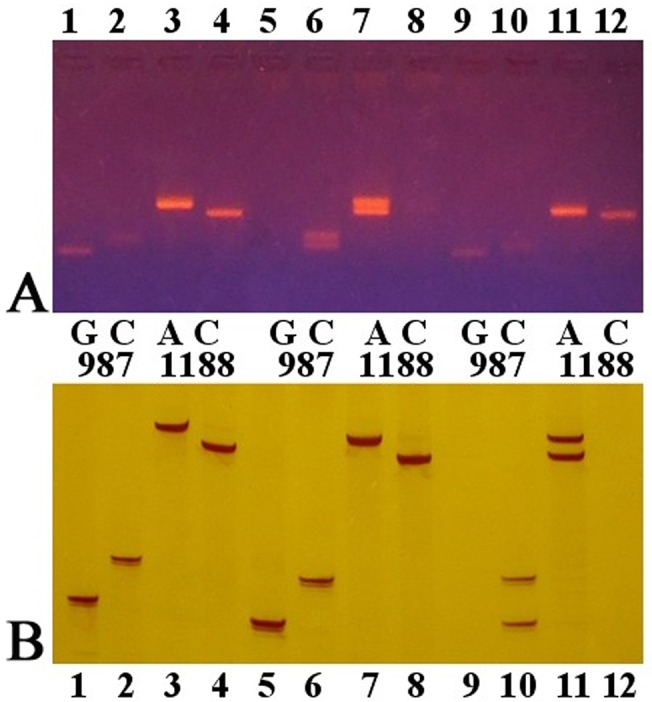
Detection of the haplotypes defined by C987GG/G987GG and TAA1118/TAC1118 via agarose gel electrophoresis (A) and polyacrylamide gel electrophoresis (B). Lanes 1–4, 5–8 and 9–12 in A and B were PCR products from 6 different individuals.